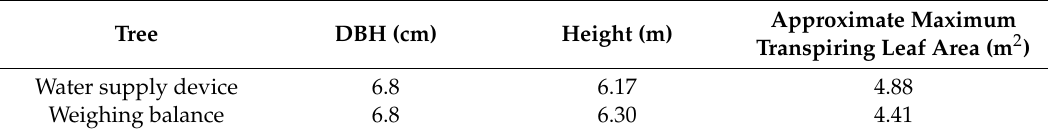
Table 3. Size characteristics of two individuals of Sorbus aucuparia . DBH = stem diameter at breast height. See Section 2.4.2 for the calculation of the leaf area.